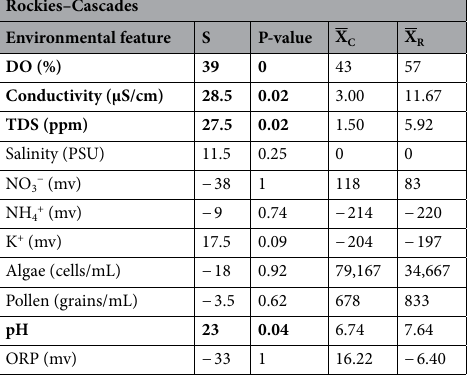
Table 1. Wilcoxon Rank-Sum tests (S) of environmental features between snow algae blooms in the Rockies and Cascades. Mean environmental features are also shown for the Cascades ( X C ) and Rockies ( X R ). Significant values are in [ bold